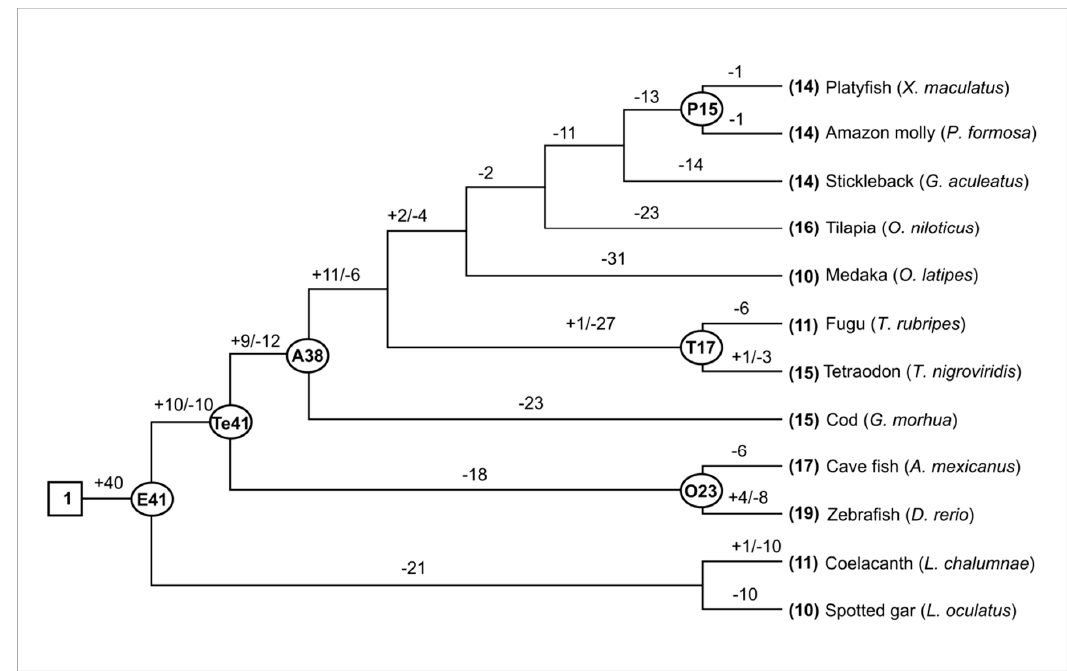
Figure 1. Gene gain and loss of Aqp in the evolution of twelve fishes. The names of internal nodes are abbreviated as E: Euteleostomi; Te: Teleostei; A: Acanthomorphata; P: Poeciliinae; T: Tetraodontidae; O: Ostariophysi. The numbers of common ancestors are shown at the internal nodes. Plus and minus signs indicate the gene gain and loss events, respectively.